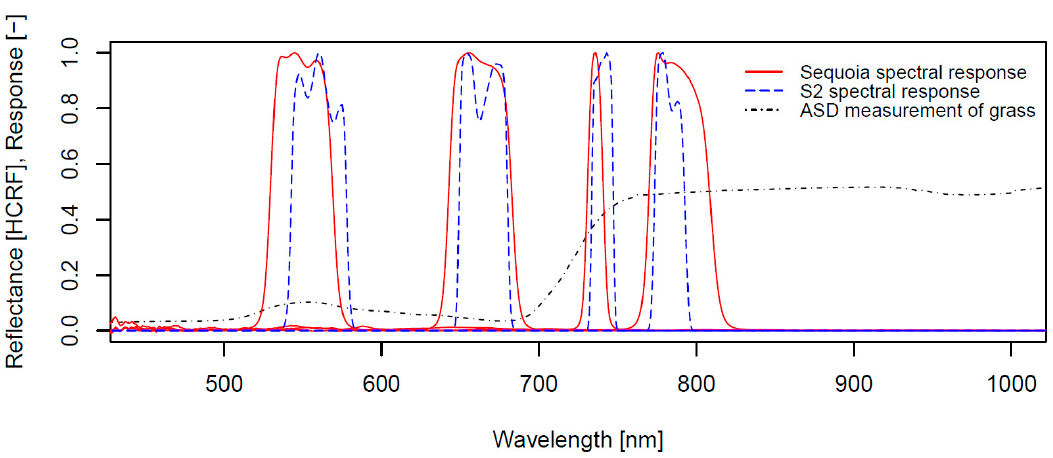
Figure 3. Relative spectral responses of the four Parrot Sequoia cameras as well as the most closely corresponding Sentinel 2A bands (bands 3, 4, 6 and 7), overlaid on a measured grass reflectance spectrum. Acquisition 1 (A1) (Table 1) denotes an acquisition for the validation of drone derived